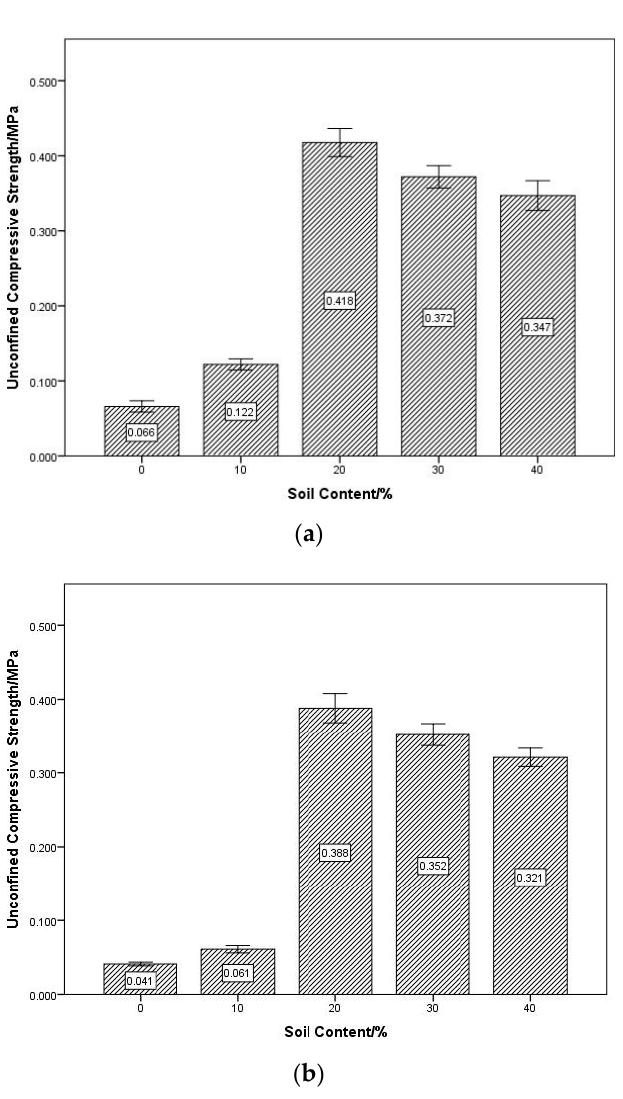
Figure 6. Unconfined compressive strength (UCS). ( a ) DS-CG; ( b ) WH-CG.